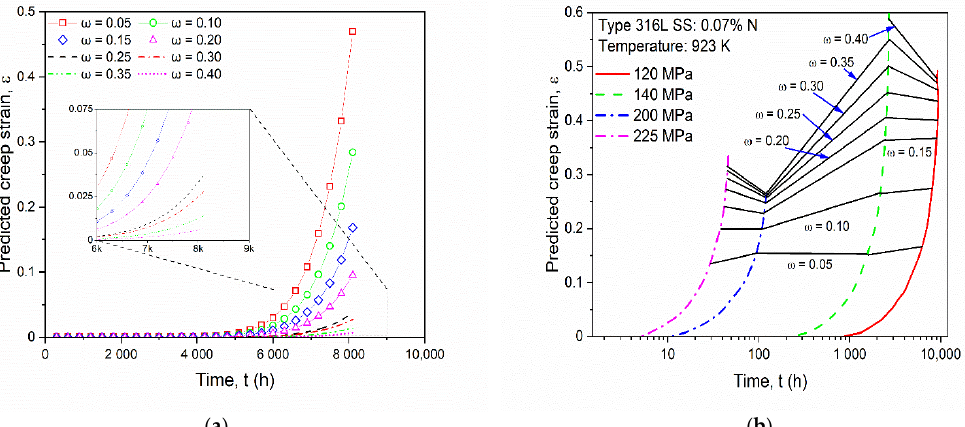
Figure 8. ( a ) Predicted creep strain at different ω values for SS-316 material. ( b )Creep strain results at various damage evolution parameters from the reference [45]. The ratio between the strain rate and the damage rate was obtained and plotted against damage variables to show the impact of the damage rate on the strain rate. From the graphs, the dominance of the damage rate was visible, which is in good agreement for the simulation and the experimental results in the combined Figure 9 [45]. Thus, the model based on the proposed curve-fitting technique was validated for the analysis.